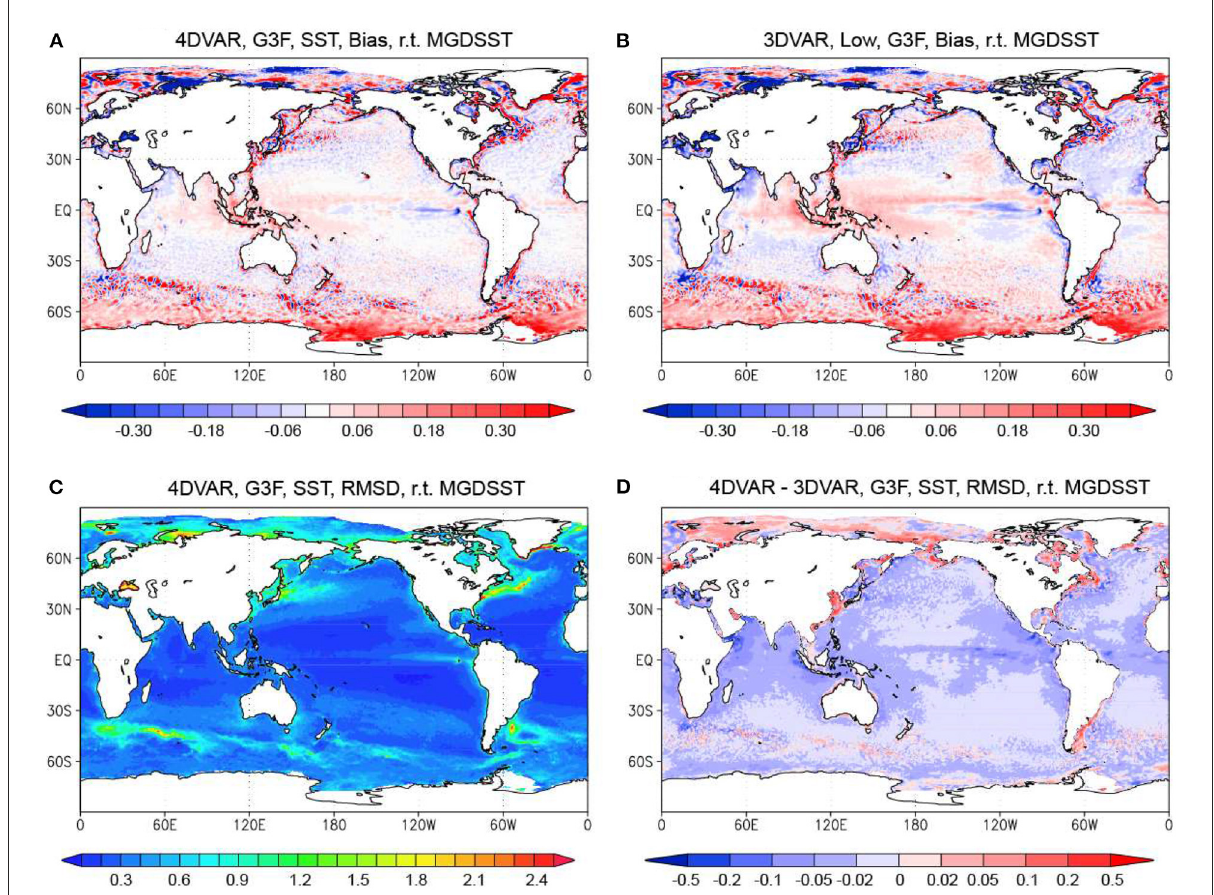
FIGURE7 Bias and RMSD of the MOVE-G3F SST for the 4DVAR and 3DVAR Runs relative to MGDSST. (A) Bias in the 4DVAR Run. (B) Bias in the 3DVAR Run. (C) RMSD in the 4DVAR Run. (D) Difference of the RMSDs between the 4DVAR and the 3DVAR Runs. Blue colors in (D) mean that the RMSD is smaller for the 4DVAR Run. Units in ◦